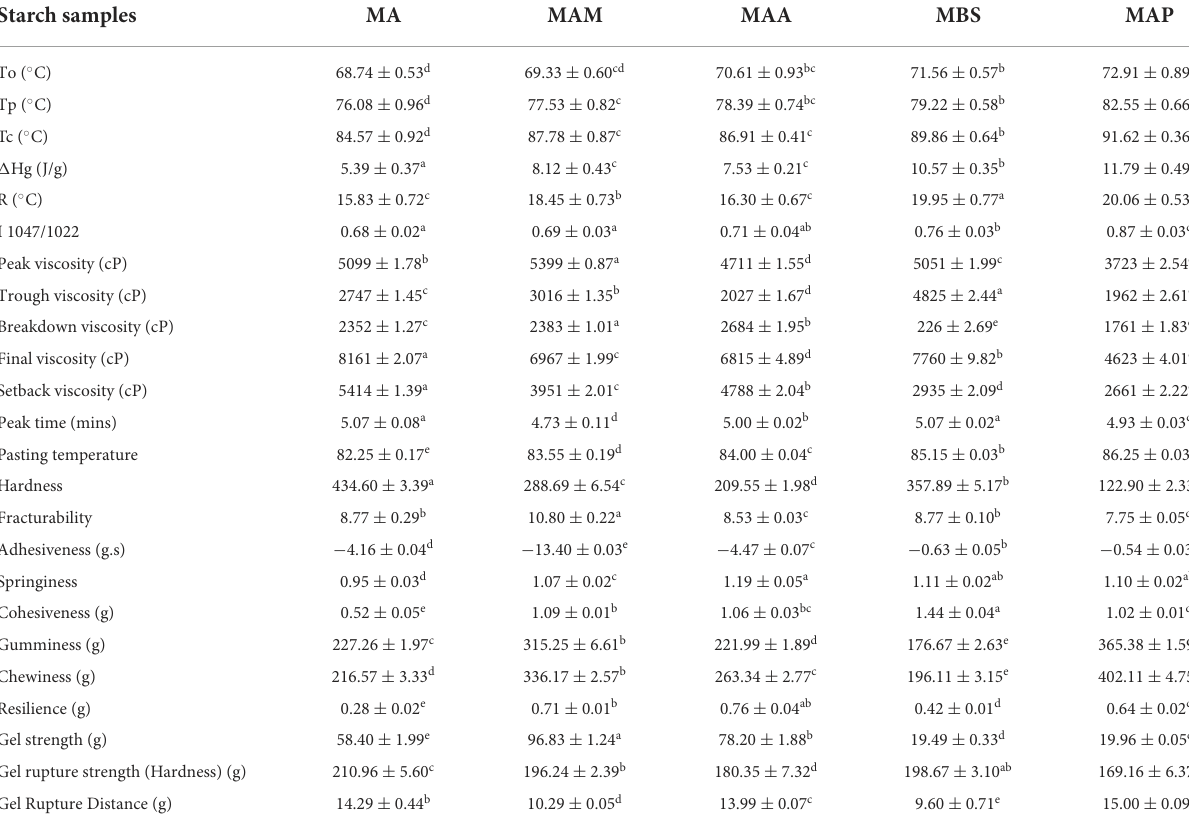
TABLE 2 Thermal properties, relative crystallinity, short-range molecular order (1,047 cm − 1 /1,022 cm − 1 ), pasting properties, and texture profiles of TPA pattern and gel 0.5 pattern of different starch samples. Starch